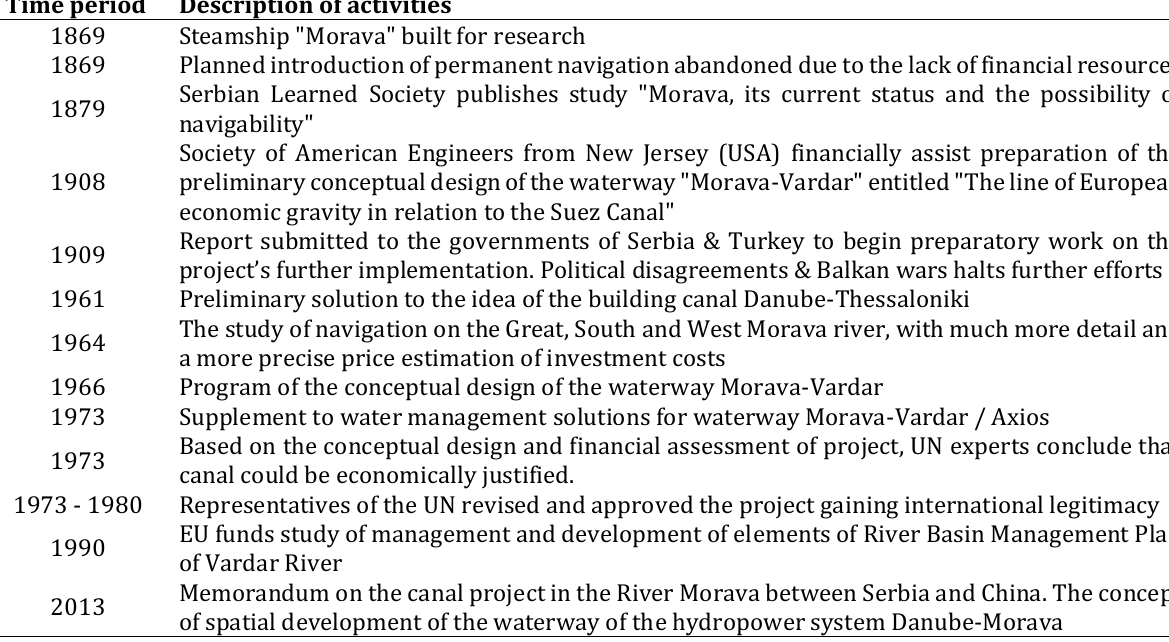
Table 1: A brief historical overview of activities related to the Morava-Vardar-Axios Canal Time